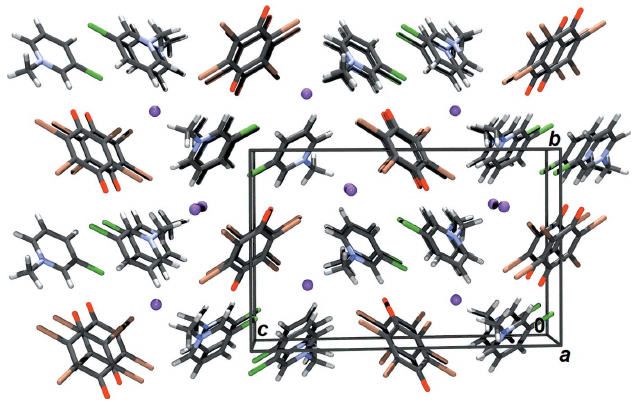
Figure 3 Crystal packing viewed approximately in the h 100 i direction. Iodide anions are shown as spheres of arbitrary radii.